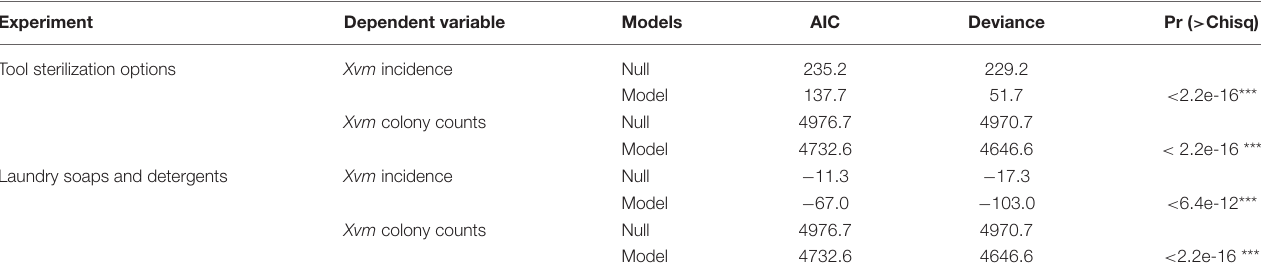
TABLE 1 | Model fit criterions comparing the null and full models for different fixed effects assessing the efficacy of different tool sterilization options on elimination of Xanthomonas vasicola pv. musacearum ( Xvm ) from farm tools.